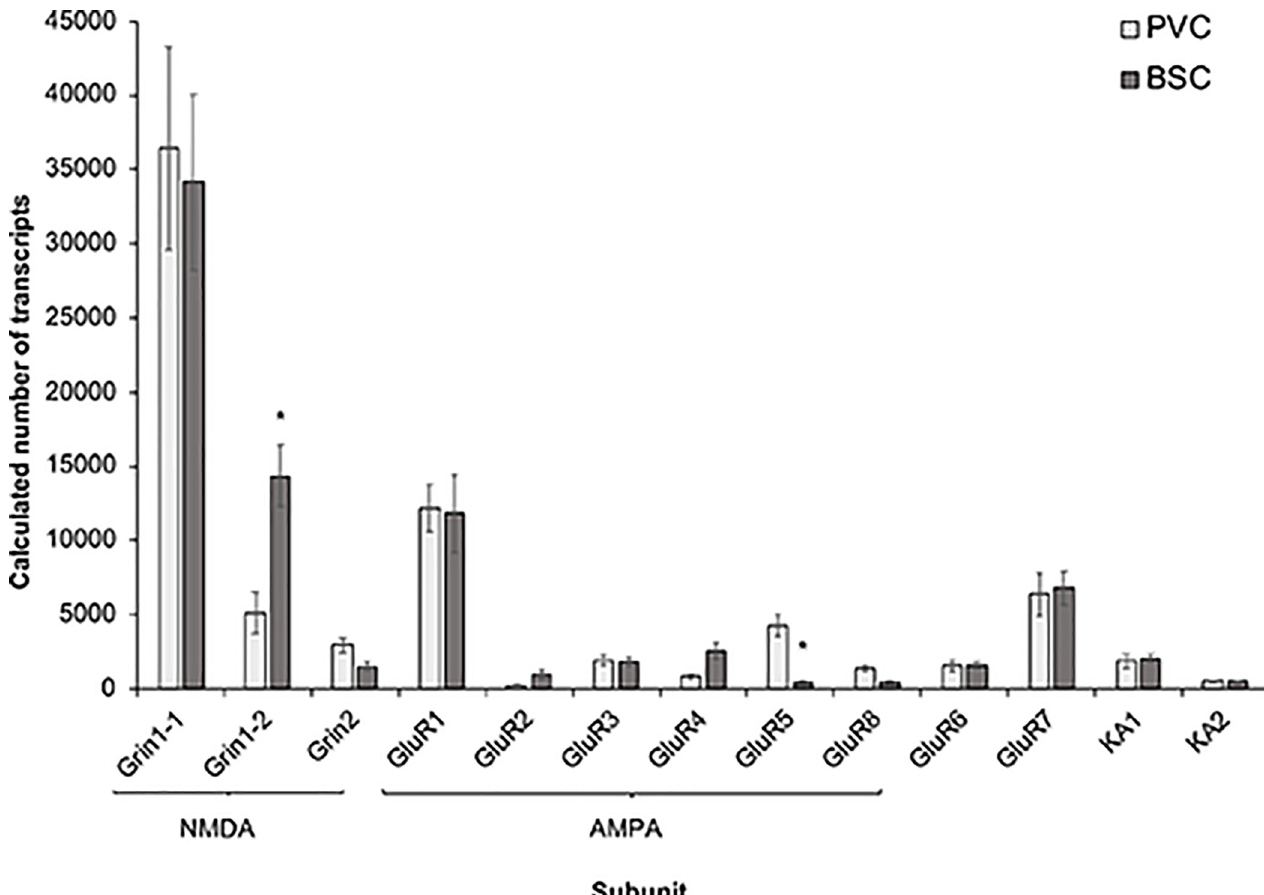
Fig 3. Comparative number of iGluR transcripts between PVC and BSC neurons. Number of transcripts is calculated per 100 ng of RNA from M animals only. � denotes significant differential expression (p � 0.05, Student’s t-test, Holm-Bonferroni correction).